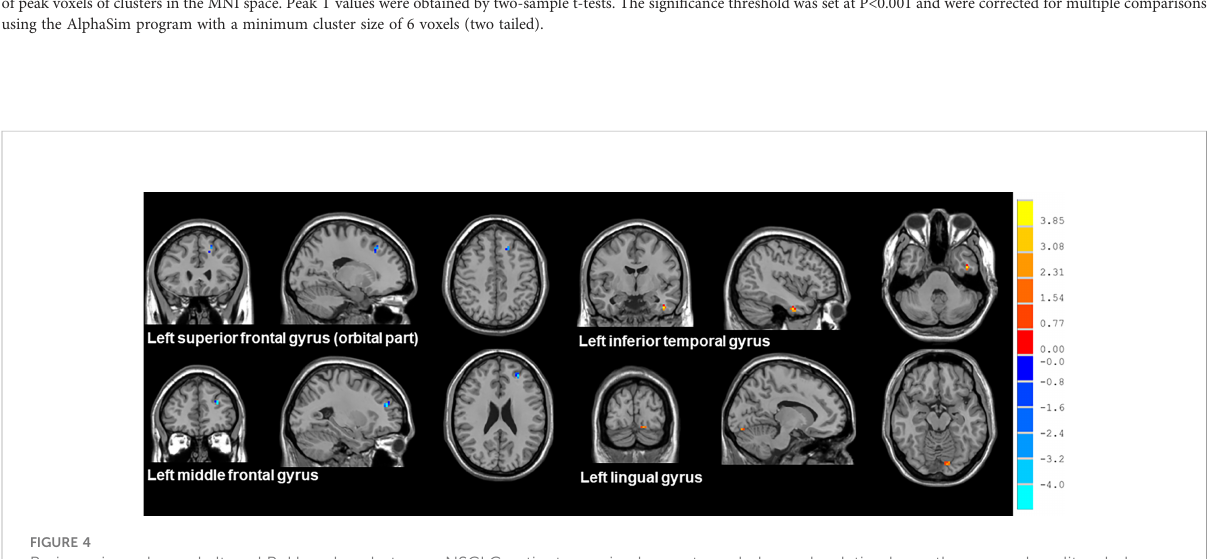
using the AlphaSim program with a minimum cluster size of 6 voxels (two